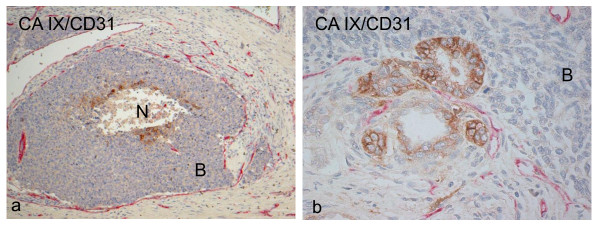
Perinecrotic staining of CA IX (brown) away from CD31-stained vessels in red (a). Membranous CA IX staining (brown) of tubules adjacent to blood vessels highlighted by CD31 staining (red) (b). N = necrosis; B = blastema.